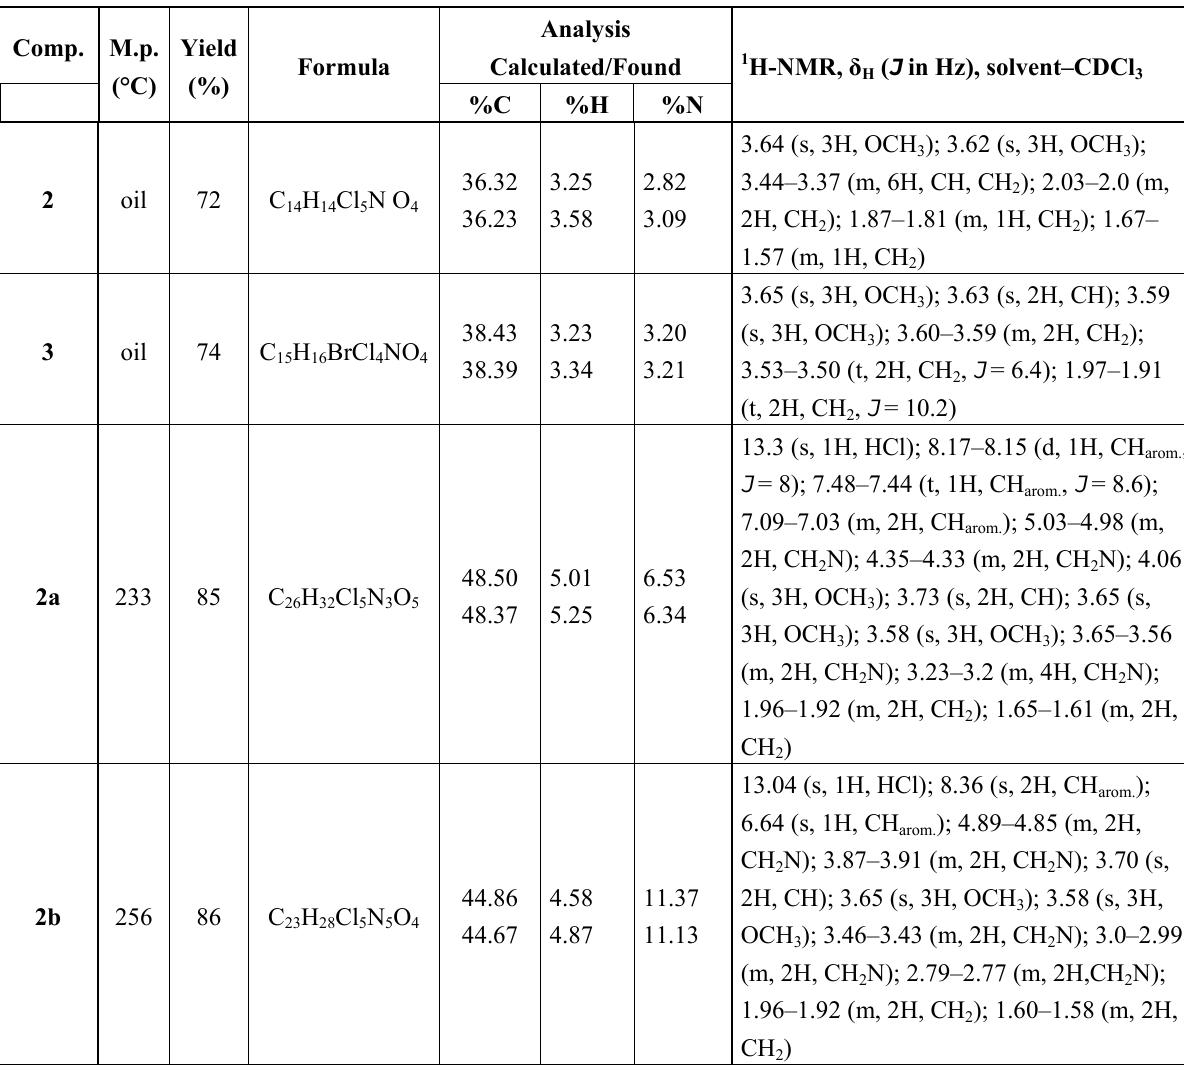
Table 1. Physical and analytical data of compounds given in Scheme1. Comp.